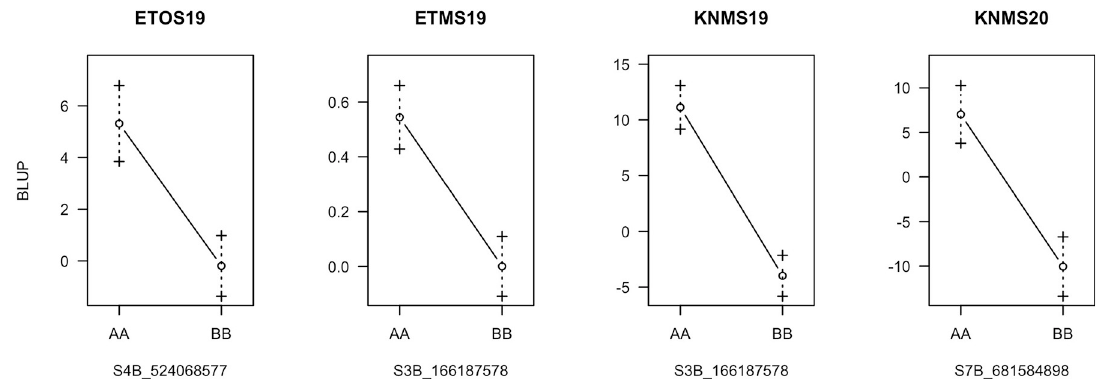
Fig 8. Effects of QTL on the response of RILs across the testing environments, the A allele was from the susceptible parent (‘DAKIYE’) and the B allele was from the resistant parent (‘Reichenbachii’).